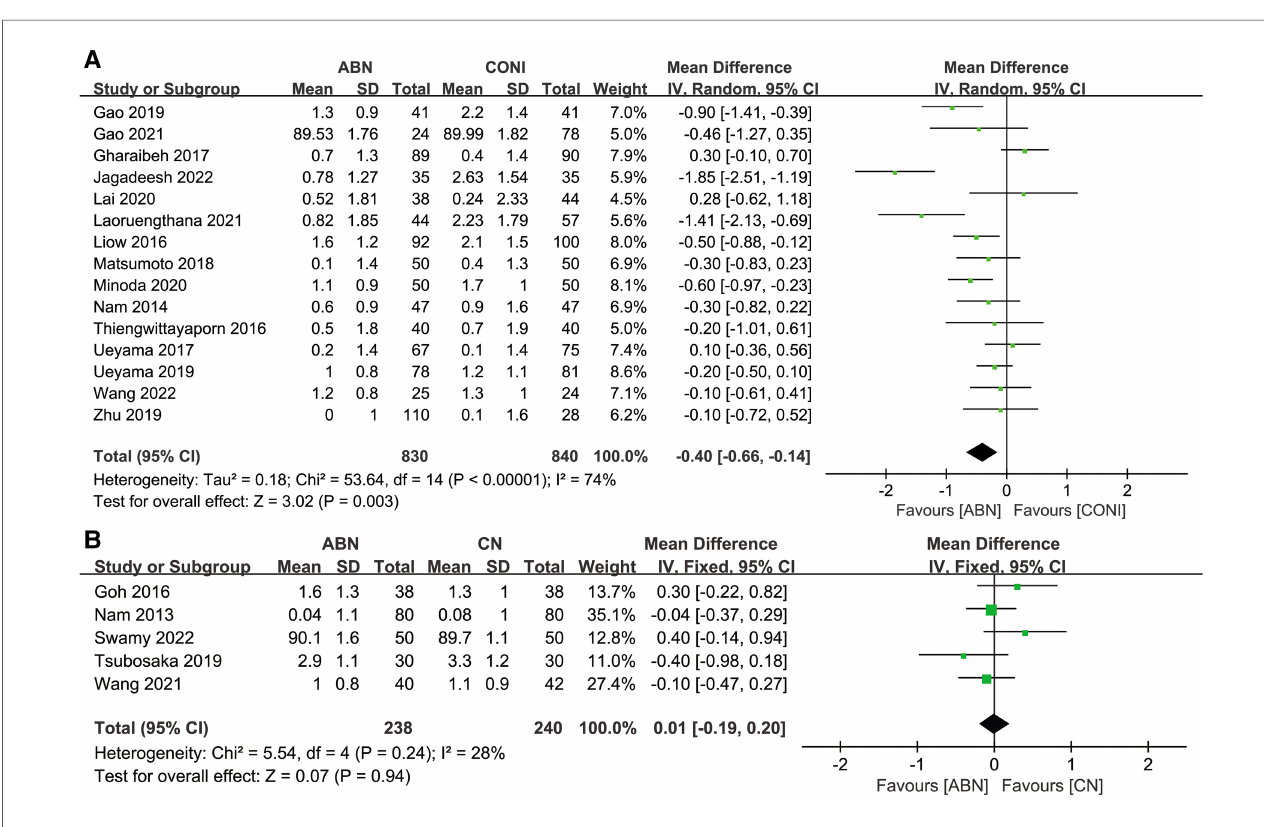
( Figure 11B , MD: 0.74, 95% CI: − 1.15 to 2.63, P = 0.44, I 2 = 0%).